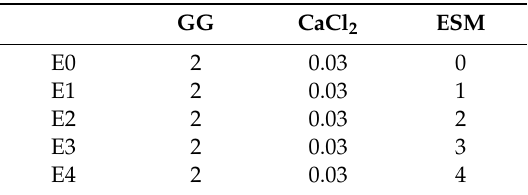
Table 1. The compositions ( w / v %) of the mixtures used to prepare five types of eggshell membrane (ESM) / gellan gum (GG) hydrogels. GG CaCl